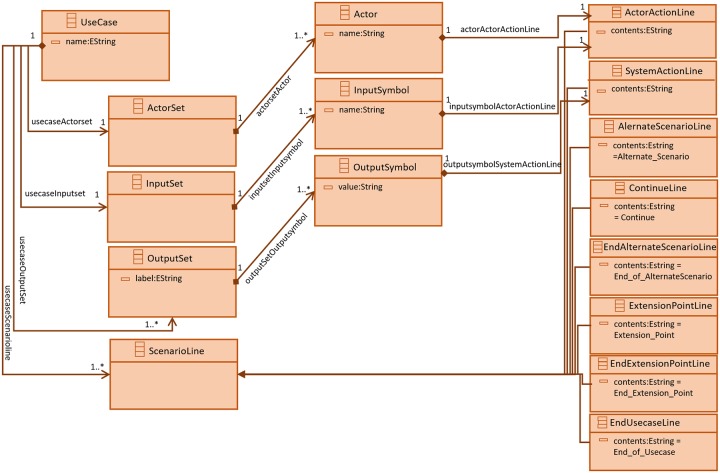
Use case meta-model.